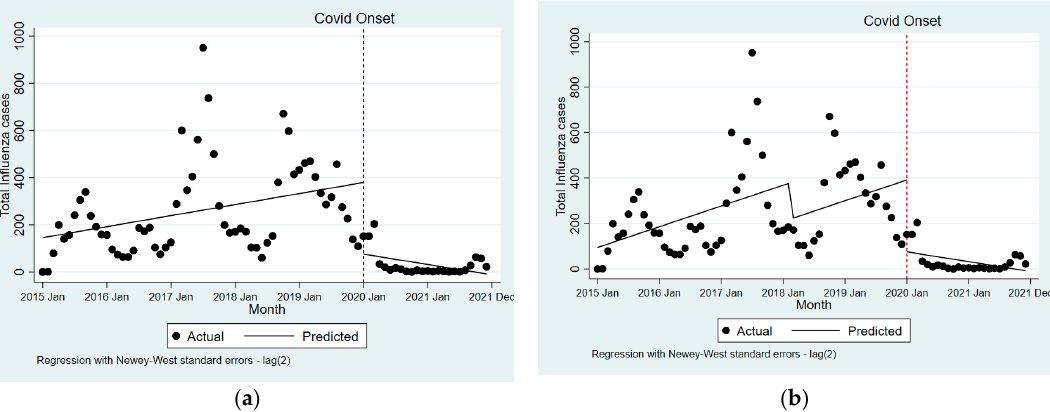
Figure 4. Interrupted time series showing the unadjusted and adjusted linear trend in the number of influenza cases detected each month at MIV, Karnataka, India during pre-COVID-19 (segment-1) and COVID-19 periods (segment-2). ( a ) Total influenza cases detected; ( b ) total influenza cases detected adjusted for charges for testing; Segment-1: pre-COVID-19 (2015–2019), Segment-2: COVID-19 period (2020–2021); interruption: month the first of case of COVID was reported (January 2020). Abbreviation: MIV—Manipal Institute of Virology.